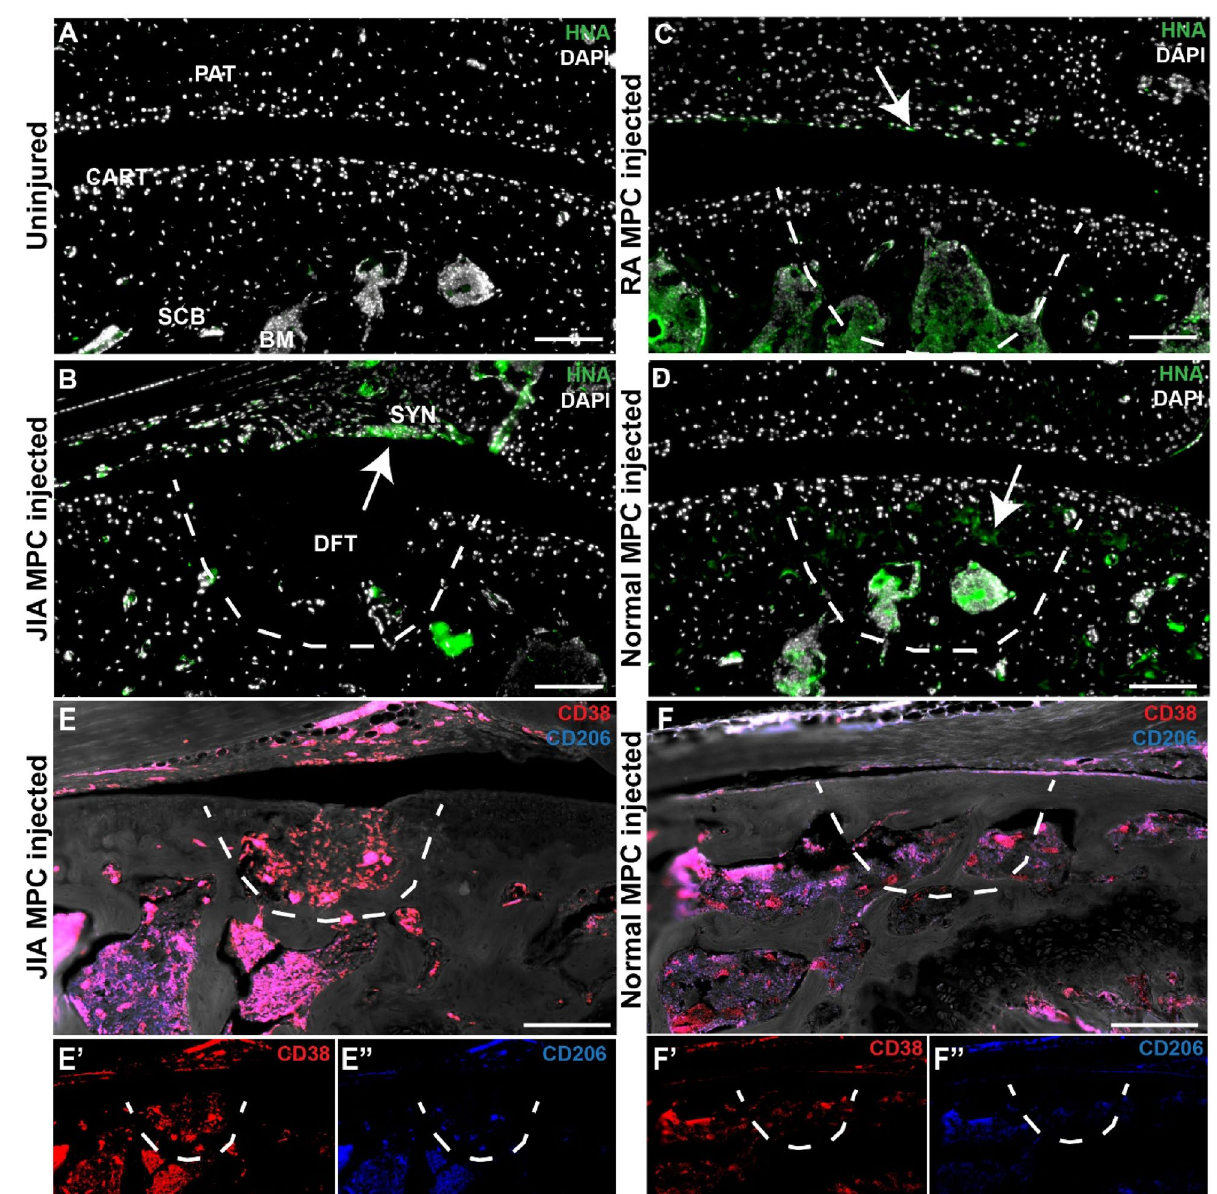
Figure 7. Transplanted human MPCs within the cartilage injury . Synovial MPCs from normal (n = 3), JIA (n = 3) and RA (n = 3) joints were injected into the injured joints of immunocompromised mice (n = 6 per group). Human Nuclear Antigen (HNA) staining was employed to detect JIA ( B ), RA ( C ) or normal ( D ) MPCs within the injury site. CD38 + ( E ’, F ’) and CD206 + ( E” , F” ) macrophages within the injury site of mice injected with JIA ( E ) or normal ( F ) MPCs. Scale bar equals 75